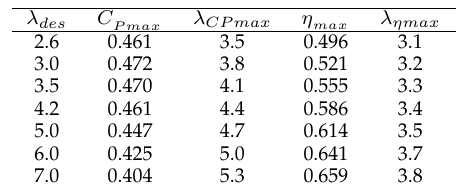
TABLE III M ODEL TURBINE : PEAK PERFORMANCE AT DIFFERENT DESIGN λ des